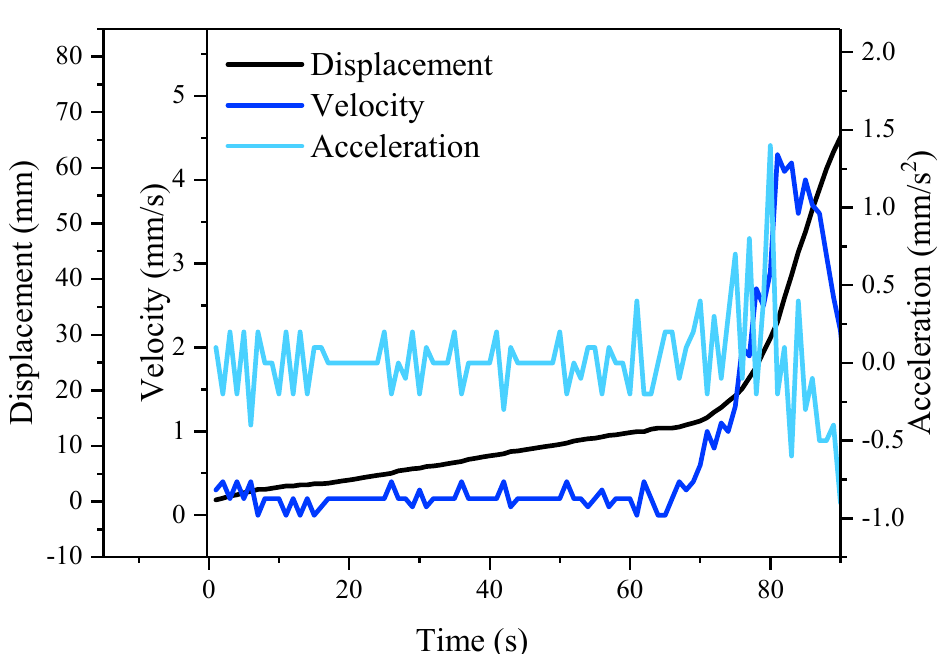
Figure 3. Displacement, velocity and acceleration of sliding body plotted against time.